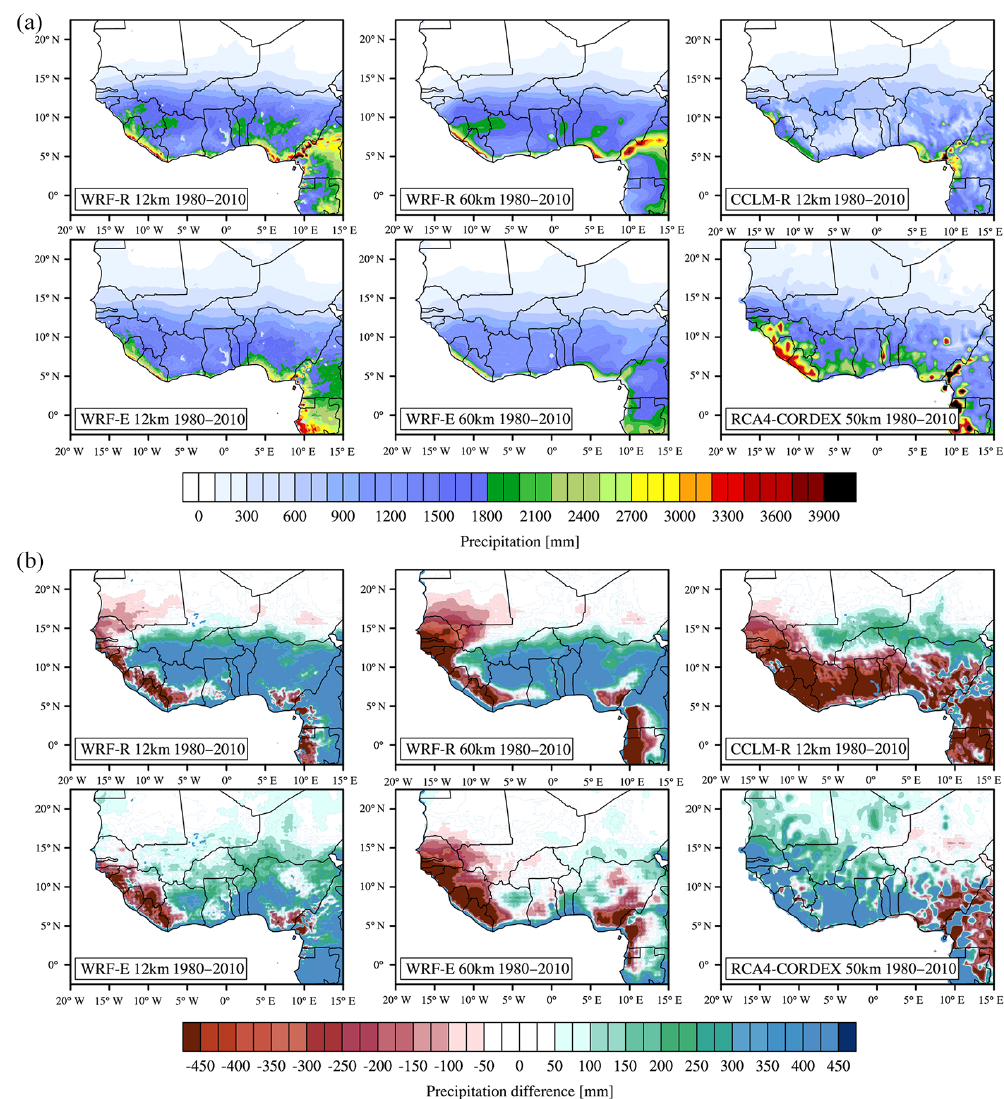
Figure 5. Annual precipitation averaged over the historical reference period 1980–2010 (a) and differences to AgMERRA reanalysis data (b) for the WRF control runs WRF-R, the WRF multi-model ensemble WRF-E, a CCLM control run CCLM-R and a two-member ensemble